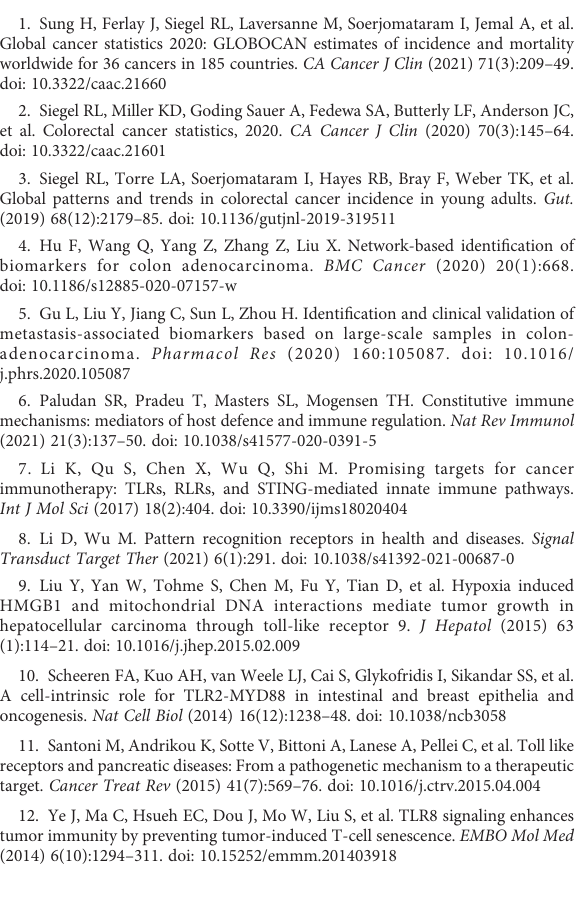
SUPPLEMENTARY FIGURE 3 C-index in different risk